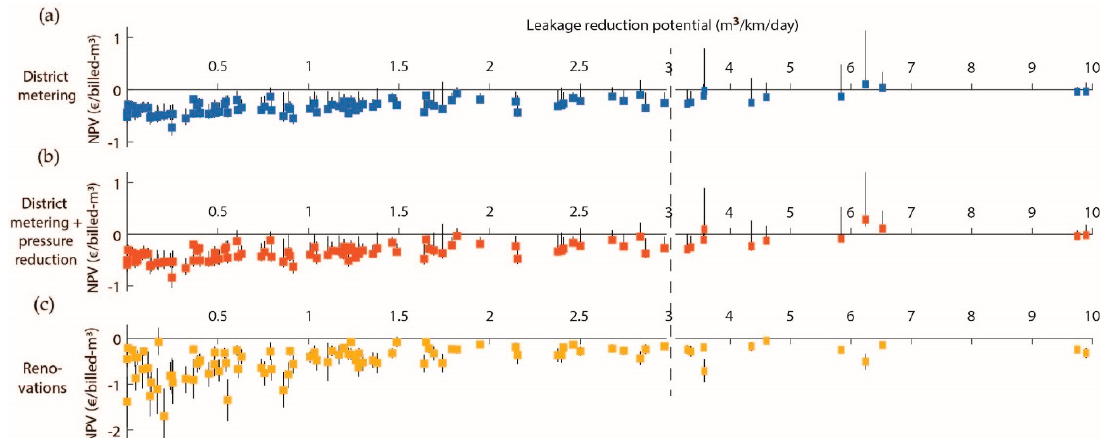
Figure 5. Net present values (euros) per total billed volume of water in m 3 for: ( a ) District metering; ( b ) District metering with pressure reduction; and ( c ) Renovations in relation to the leakage reduction potential. The simulated 10 th to 90 th percentile values are indicated by the error bars. Note that the scale of the x-axes changes at 3 m 3 /km/day. Water 2020 , 12 , x FOR PEER REVIEW 12 of 15